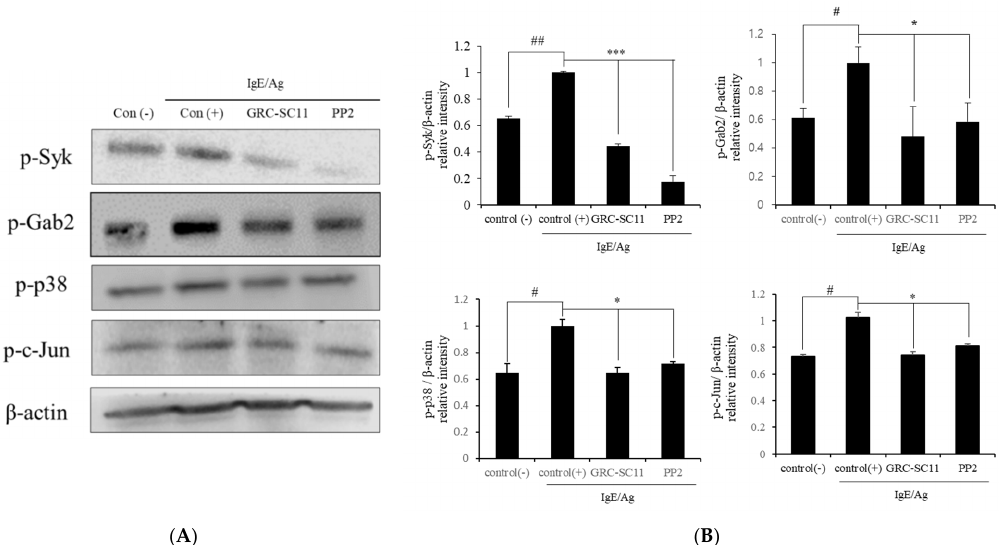
Figure 4. Effects of GRC-SC11 on the signaling molecules IgE/Ag-activated RBL-2H3 cells. RBL-2H3 cells were sensitized with dinitrophenol (DNP)-IgE and then stimulated with antigen for 15 min. ( A ) Western blotting assay of phospho-spleen tyrosine kinase (p-Syk), Syk, phospho-GRB2-associated binding protein 2 (p-Gab2), Gab2, p-p38, and p-c-Jun. ( B ) Expression levels of GRC-SC11. The levels were normalized to β -actin levels. The experiments were repeated three times and results are presented as the representative or mean ± SD. The probability values of # p < 0.05 and ## p < 0.01 were considered to be significant compared to the non-treated cells, and * p < 0.05 and *** p < 0.001 compared to the IgE/Ag treated cells. One-way ANOVA was used for the comparison of group means, followed by Dunnett’s t -test.